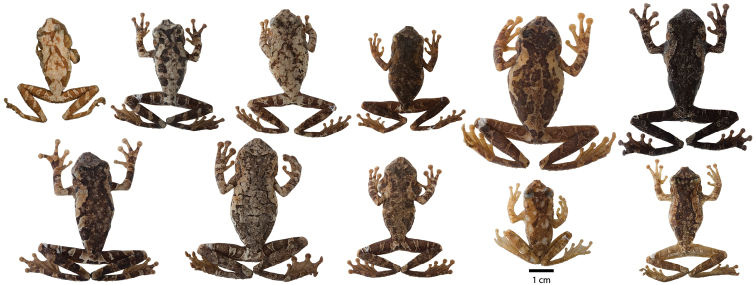
Variation in dorsal coloration of preserved specimens of adult Osteocephalus buckleyi. Left to right, upper row: BMNH 1947.2.13.44 (Lectotype), QCAZ 38704, EPN-H 6374, 11718 (males), QCAZ 2876, 14948 (females); lower row: QCAZ 39799, 26552 (females), 26488, 26561, 39364 (males). Provincia Napo, Orellana, Pastaza and Sucumbíos, Ecuador (See Appendix I for locality data). All specimens are shown at the same scale.